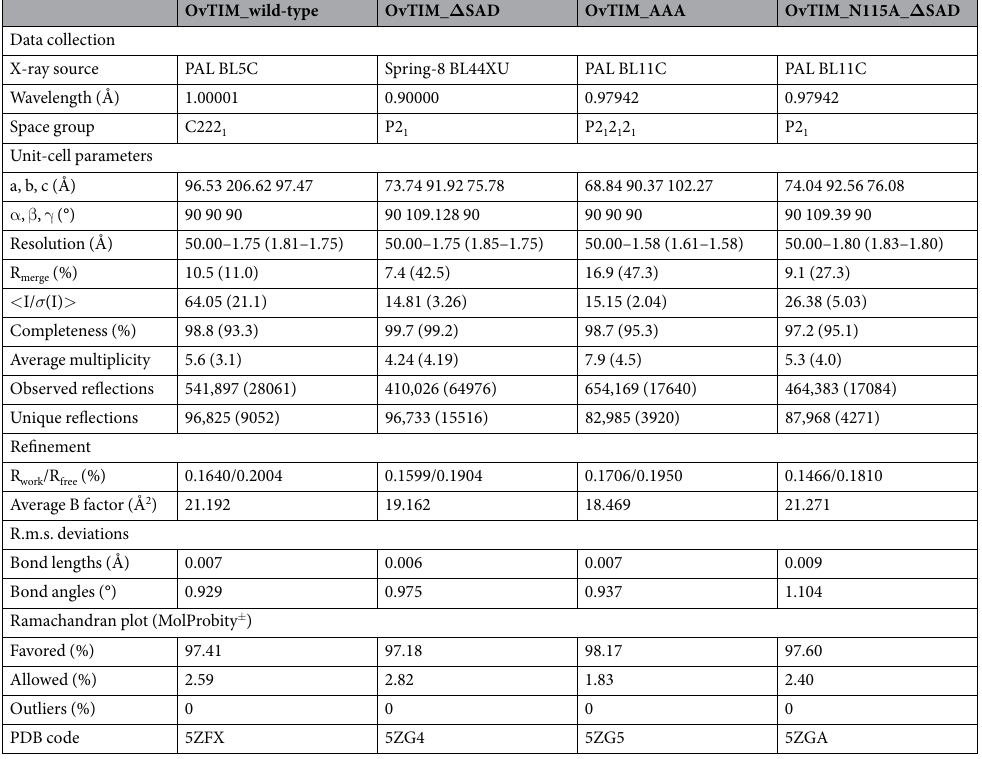
Table 1. Statistics for X-ray data collection and